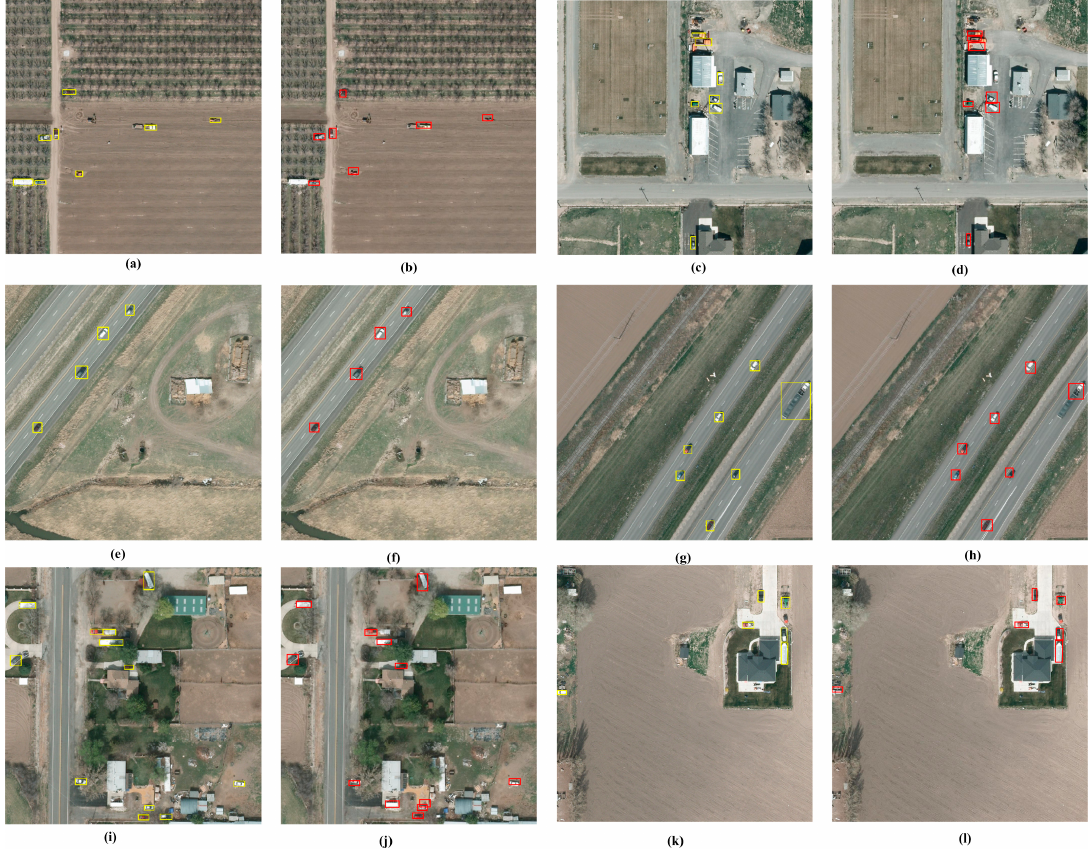
Figure 9. ( a – l ) some detection examples of VEDAI dataset.